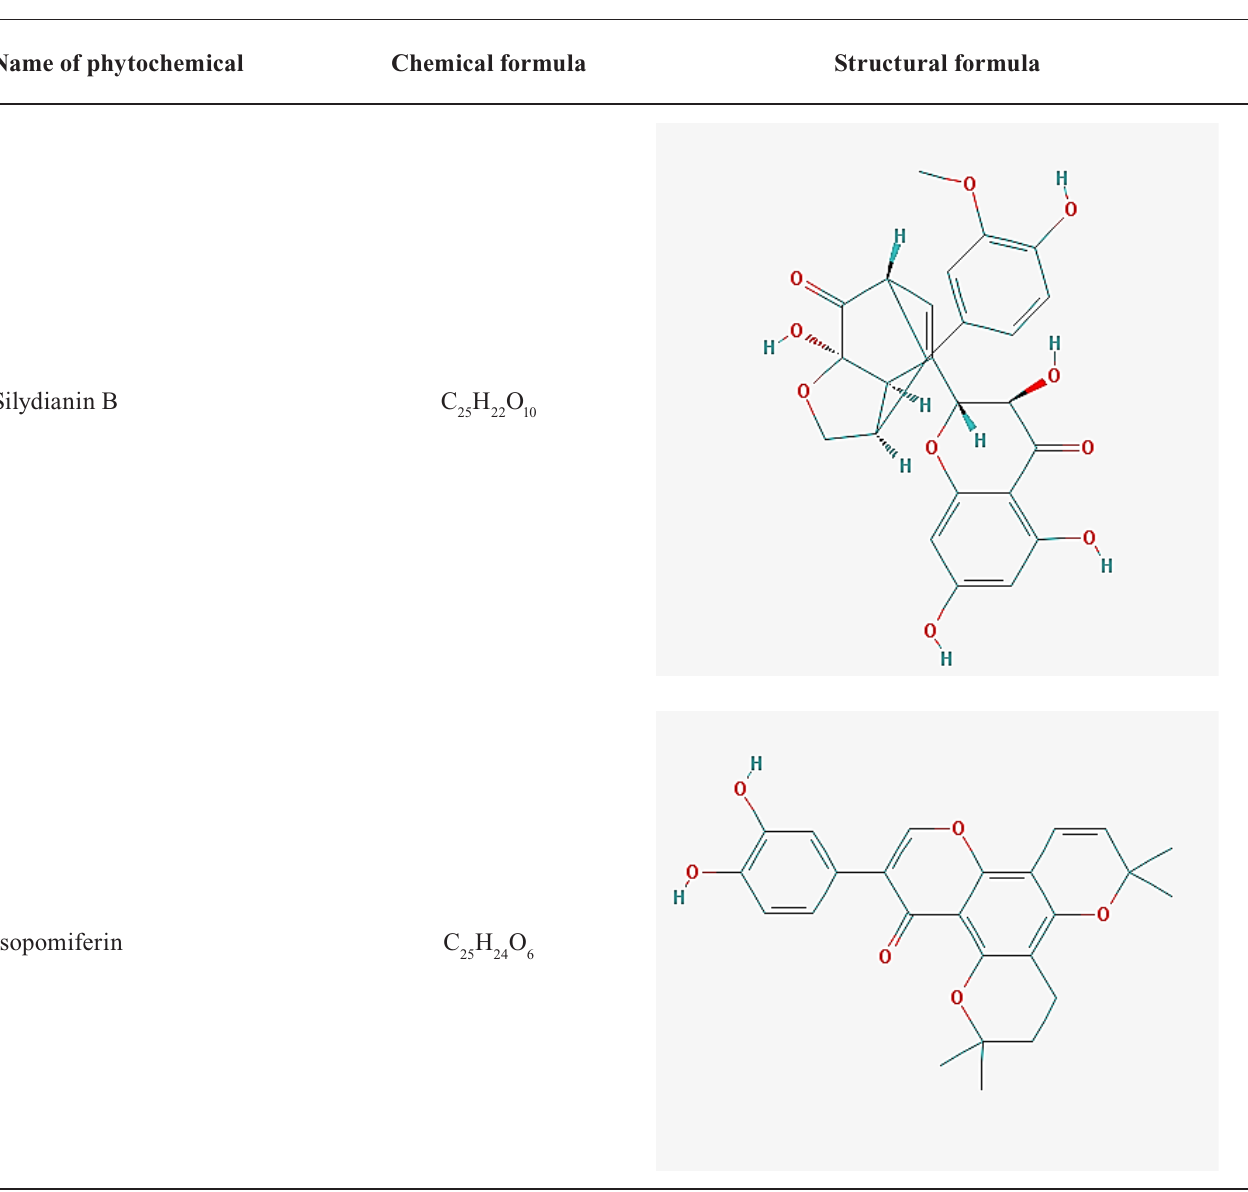
TABLE I - P hytochemicals from Tanacetum parthenium and Silybum marianum